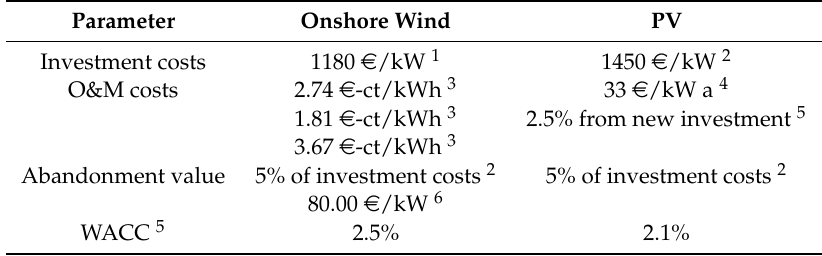
Figure 7. Changes in installed capacity of selected renewable energy technologies in Germany due to subsidy expiry. Source: IAEW, RWTH Aachen University, based on data from [52]. Table 2. Economic parameters used in the case study for onshore wind and PV power